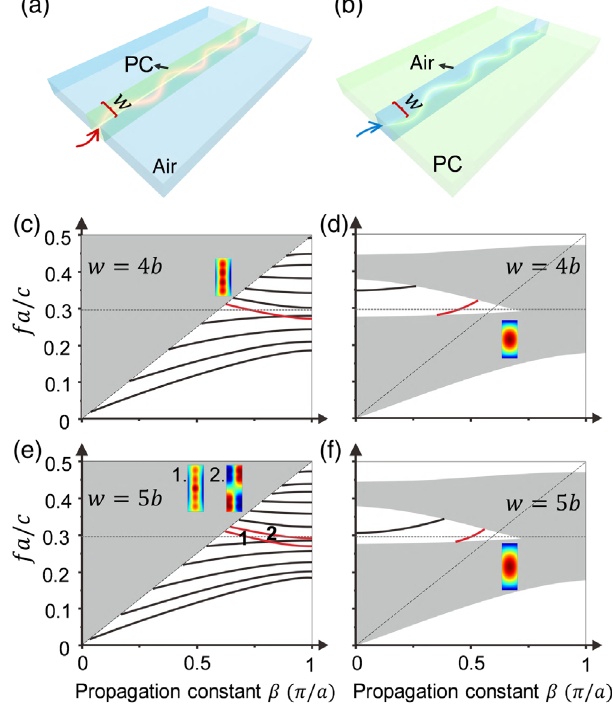
FIG. 3. Two complementary types of waveguides constructed by free space and PC II. (a),(b) The schematic diagrams of the PC channel (free-space cladding) and free-space channel (PC cladding), respectively. (c) – (f) The waveguide dispersions of the complementary PC and free-space channels with w ¼ 4 b and w ¼ 5 b . The dashed line shows the light cone, and the dotted line marks the working frequency fa=c ¼ 0 . 2962 . The inset graphs show the electric field distributions of the corre- sponding waveguide